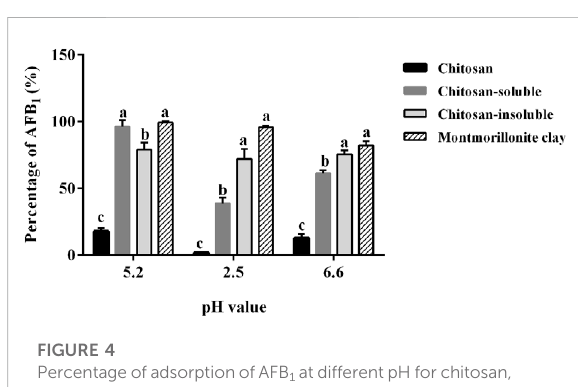
*Different letters indicate signi fi cant differences (Dunnett's test at p ≤ 0.001), same letters show no signi fi cance difference.